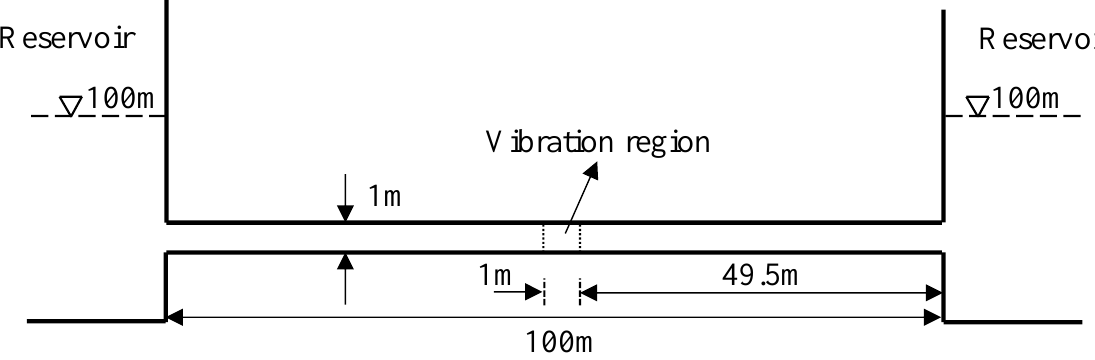
Figure 7. Schematic geometry of the vibration pipe.